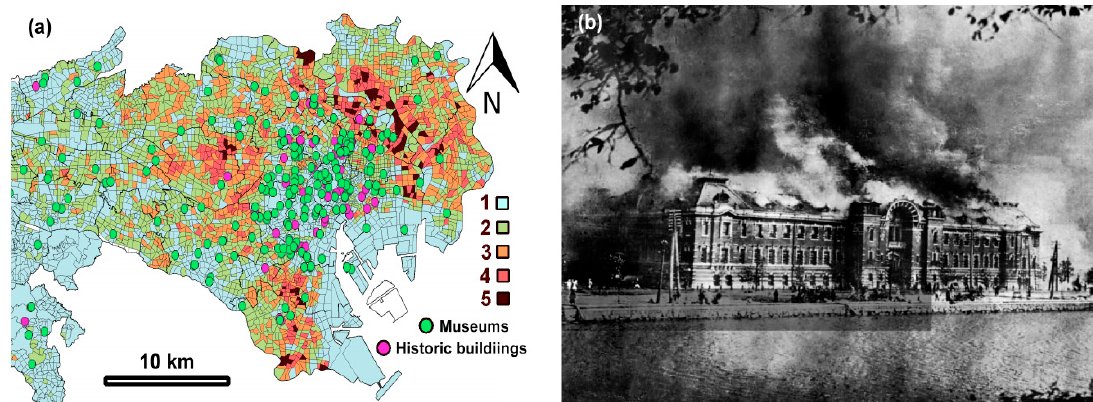
Figure 8. ( a ) Fire risk for Tokyo. Source: TMG 2018 and National Land Numerical Information (https://nlftp.mlit.go.jp/). ( b ) The Metropolitan Police Department building burning after the Great Kant ō Earthquake. Source: Public Domain—File: Metropolitan Police Office after Kanto Earthquake.jpg [60]